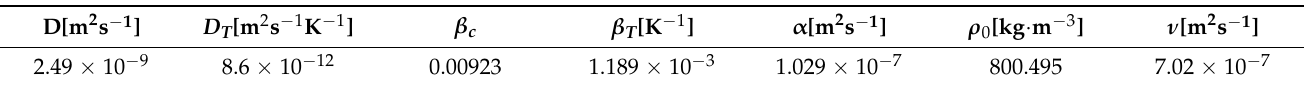
Table 1. Properties for toluene–methanol mixtures at a mean temperature of 23 ◦ C and C 0 = 18.9 wt%. See text for